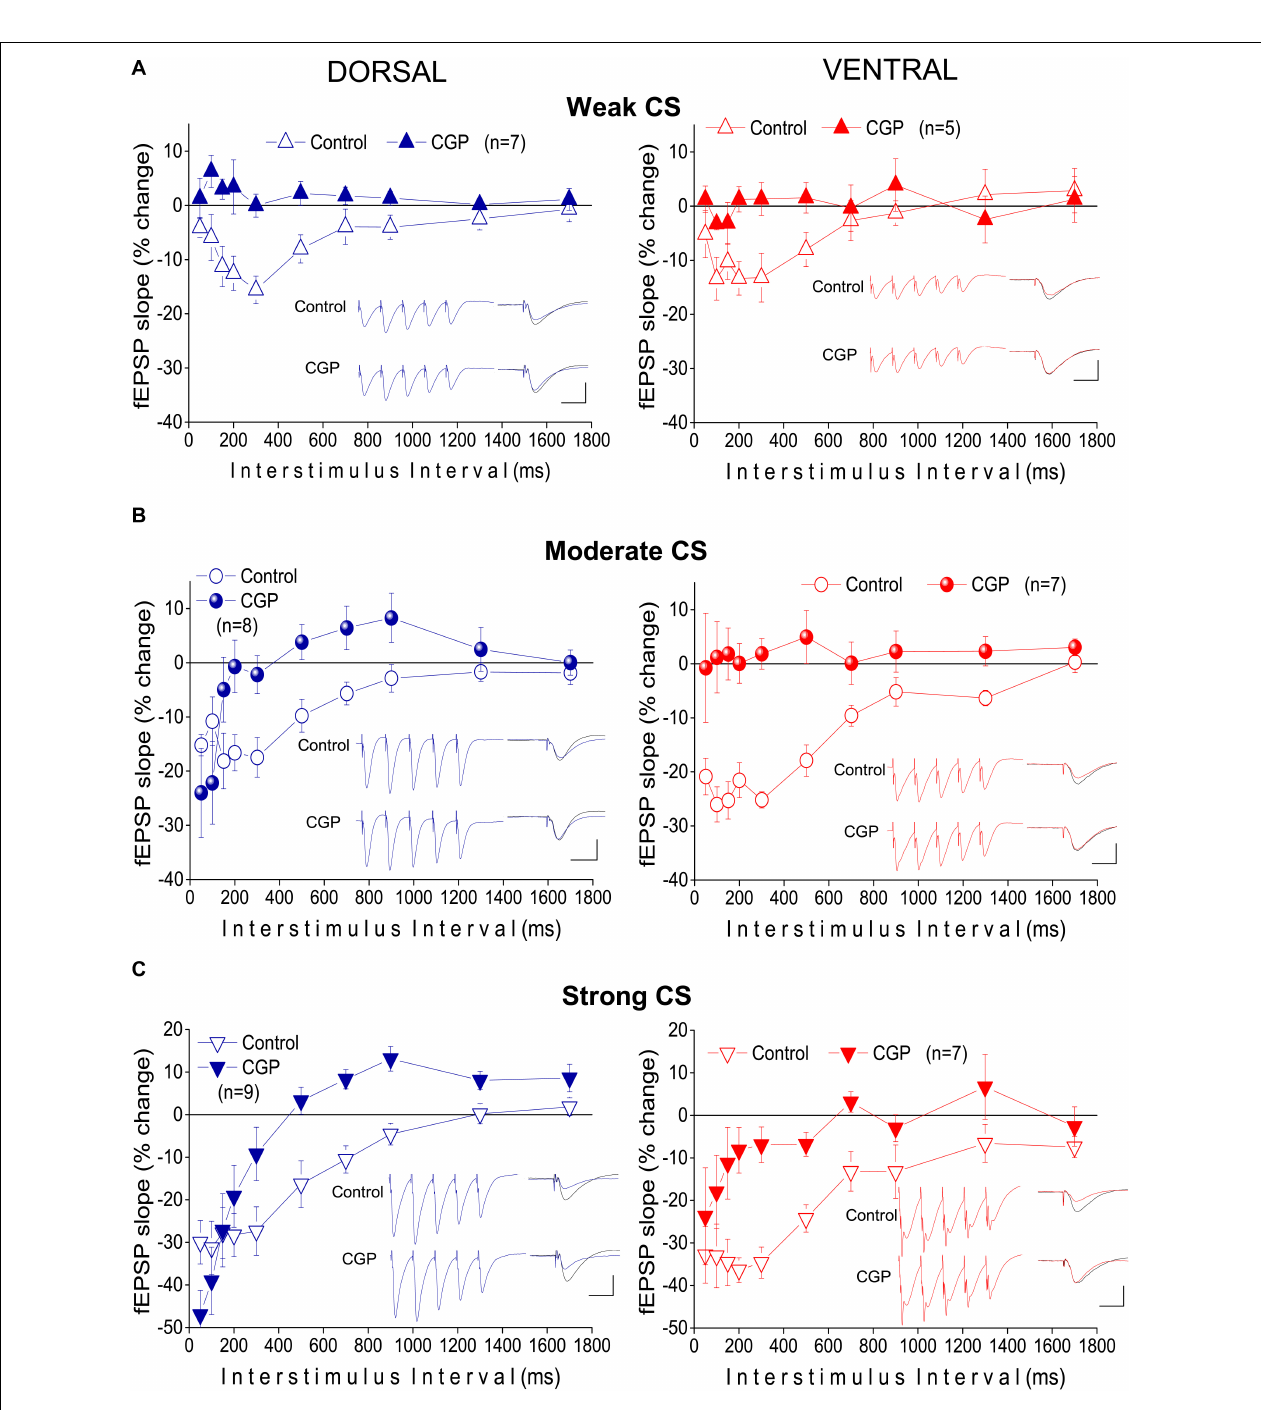
FIGURE 4 | Heterosynaptic depression depends on GABA B Rs in both the dorsal and the ventral hippocampus. Time courses of tHSD induced under normal conditions (open symbols) or blockade of GABA B Rs by their selective antagonists CGP 52432 (10 µ M) or CGP 46381 (50 µ M) (filled symbols), in the dorsal and the ventral hippocampus. Three intensities of CS, weak (A) , moderate (B) , or strong (C) were used to induce tHSD. Numbers into parenthesis indicate the number of slices used. Insets are examples of fEPSP recordings for an inter-stimulus interval of 200 ms; a 150 ms-long interval between conditioning and test response is omitted for clarity reasons. Traces in black denote control responses of the conditioned path. Calibration bars: 1 mV, 10 ms. Artifacts are truncated. Note that blockade of GABA B Rs by CGP eliminates tHSD induced by weak CS, in both hippocampal segments, and tHSD induced by moderate CS in the ventral hippocampus. However, significant tHSD induced by moderate CS under blockade of GABA B Rs remained in the dorsal hippocampus, at 50 − 100 ms. Also, significant tHSD induced by strong CS under blockade of GABA B Rs remained in the dorsal (50 − 200 ms) and the ventral hippocampus (50 − 100 ms).